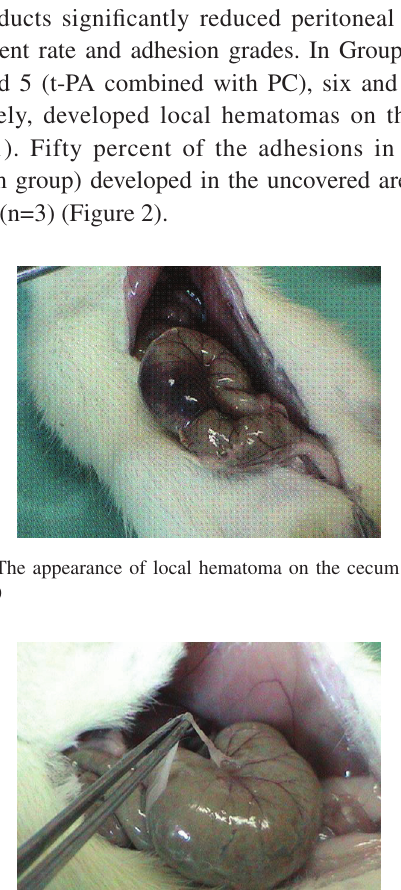
Table 2 - Postoperative adhesion rates, grades and side effects for groups